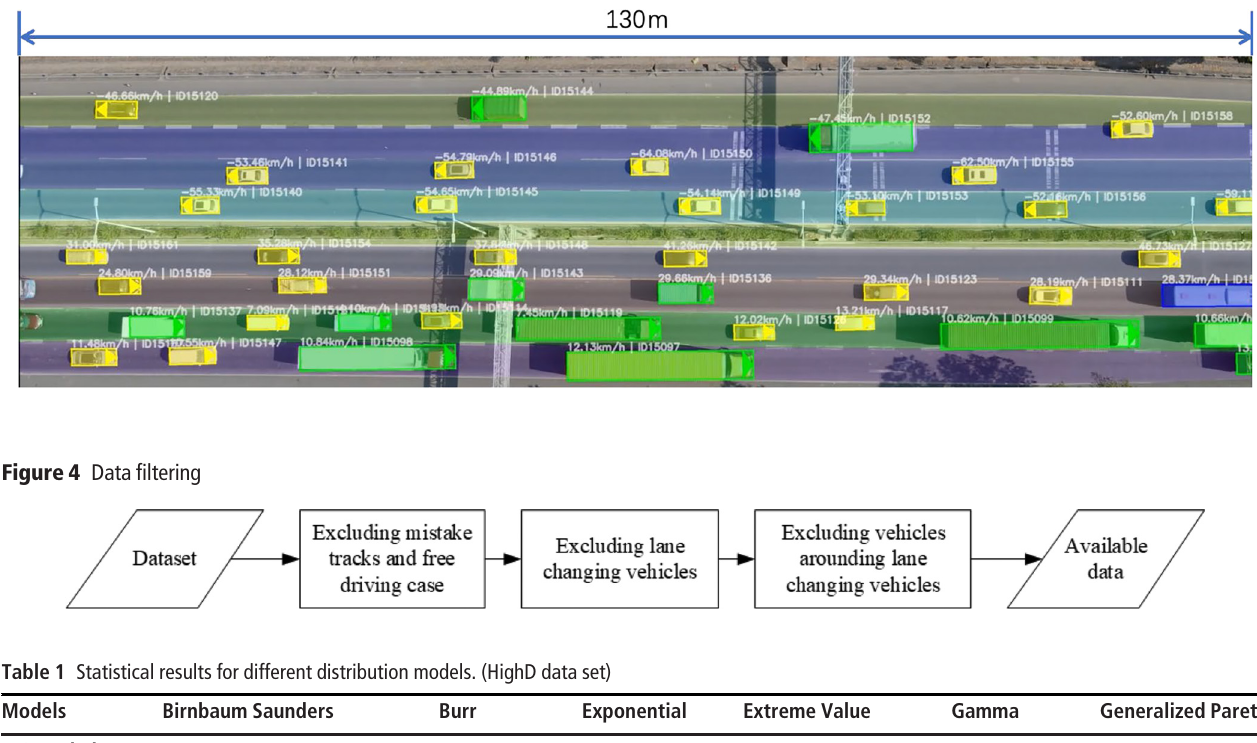
Figure 3 AD4CHE data set